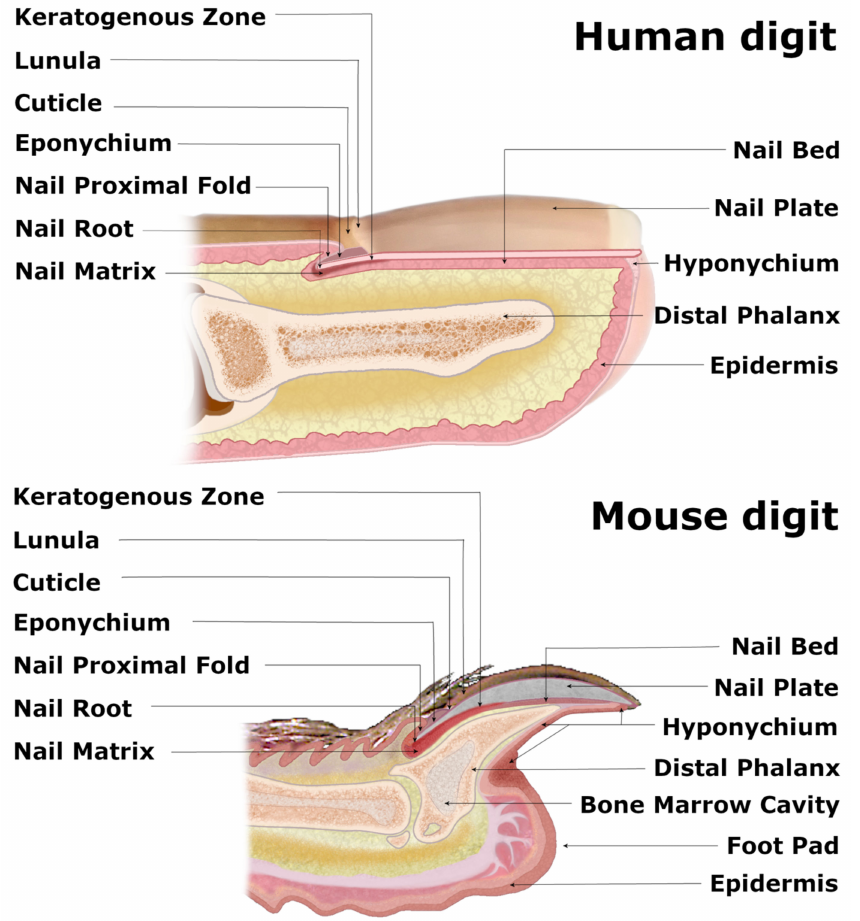
Figure 1. Comparative anatomy of human and mouse nail mini-organs. The visibly distinguishable nail organs of human and mouse digits share major characteristics across their inner structures. In both species, the wedge-shaped nail proximal fold (NPF), which smoothly transitions into the nail matrix (perceived as whitish crescent-shaped lunula), encircles the nail root of the nail plate (NP). Both flat human NP and claw-shaped murine NP lie atop of the keratogenous zone (KZ) and the nail bed (NB) and are protected with eponychium at the nail root and the hyponychium underneath the distal end of the NP. The triangular-shaped bone of the murine digit and splayed terminal phalanx of the human appendage enclose the bone marrow